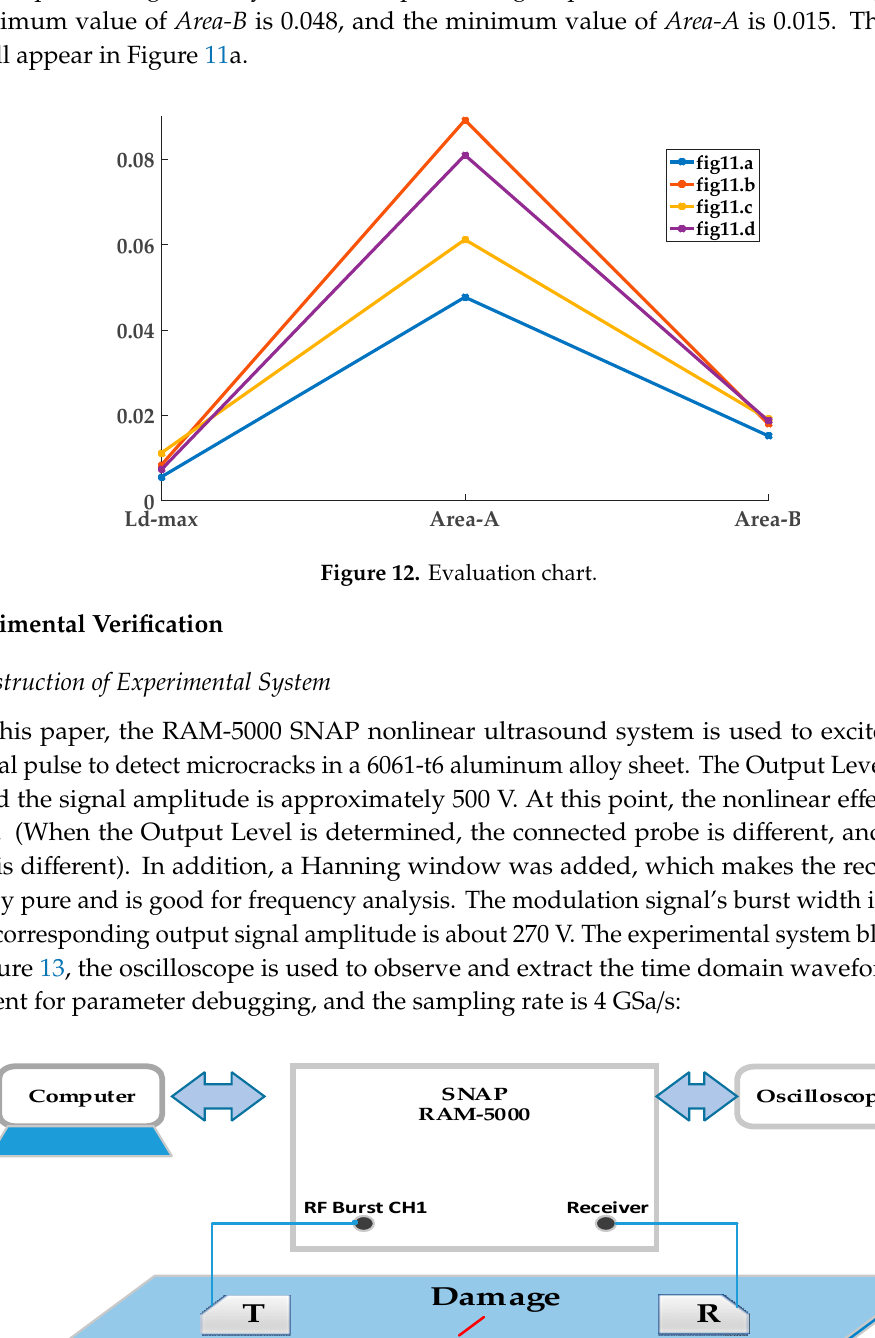
( b ) Figure 14. Signal processing: ( a ) Original waveform; ( b ) waveform filtered by EMD. As can be seen from the above figure, EMD decomposes the original signal into intrinsic mode functions of different frequencies and removes the frequency higher than the second harmonic for signal reconstruction. After EMD filtering, the signal-to-noise ratio of the signal is obviously increased. The center frequency of the 0.5P13*13 adjustable angle probe is 0.5 MHz and it is used to excite the 0.5 MHz lamb wave. Signal reception uses a 1P13*13 adjustable angle probe to better receive the second harmonic because of its 1 MHz center frequency. Excitation and reception probes are matched with RAM-5000 SNAP by BNC. The wedges are made of plexiglass, which is the key to exciting the S0 mode lamb wave. The coupling agent uses glycerin. The microcracks are produced by tapping and are about 3 mm long. The physical map of the microcrack is shown in Figure 15. The microcrack center point is still used as the coordinate origin, and the crack extends along the y-axis. Through simulation comparison, it can be seen that the microcrack positioning map is ideal when the receiving 0